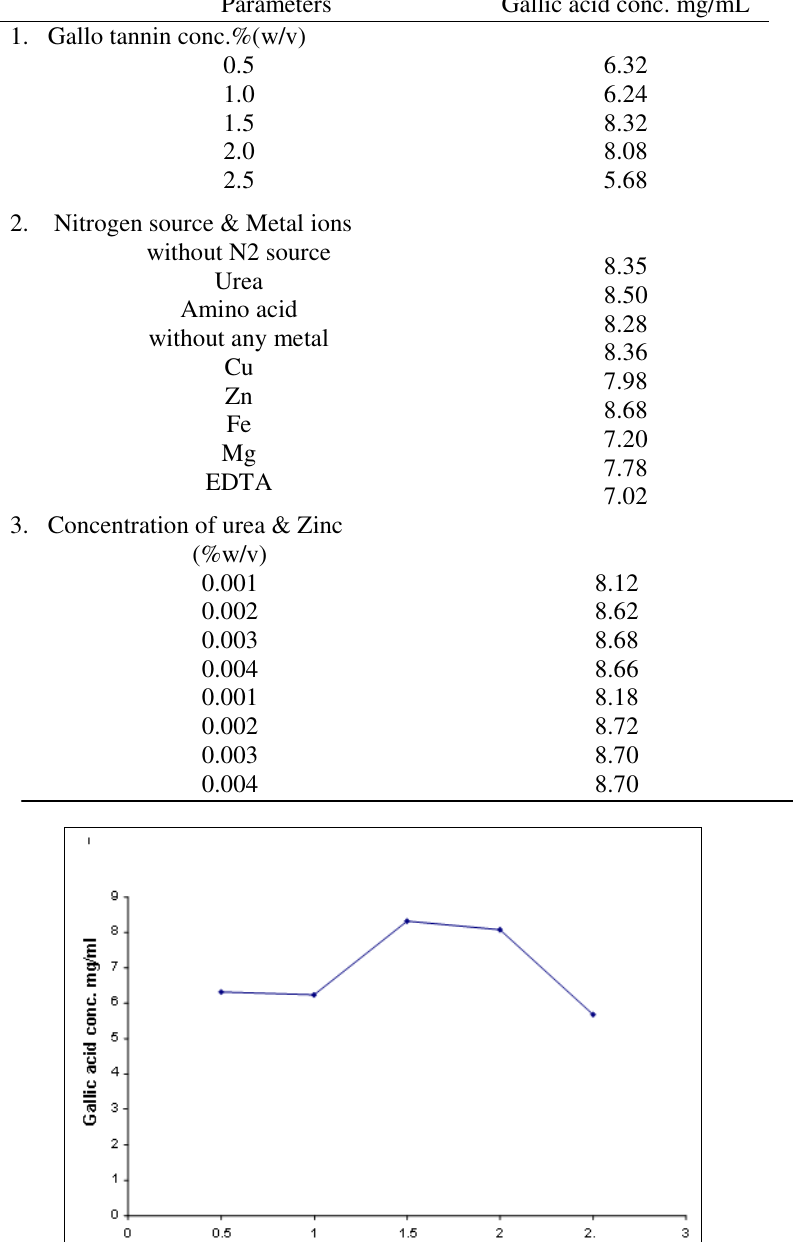
Table 1 . Effect of some parameters on the hydrolysis of gallotannin to gallic acid by fungi A. niger Parameters